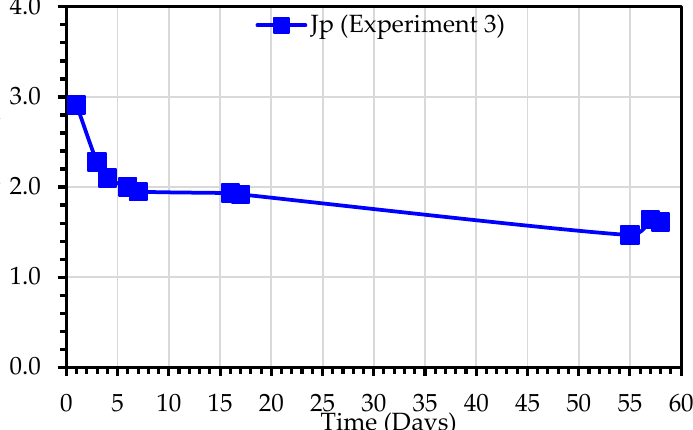
Figure 10. Permeate flux observed during treatment of primary wastewater using a hybrid DCMD system (Experiment 3).